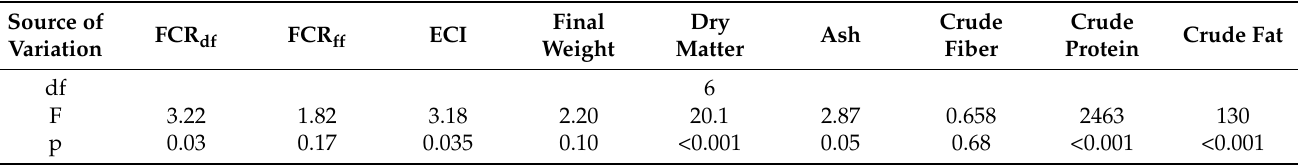
Table 3. Results of one-way